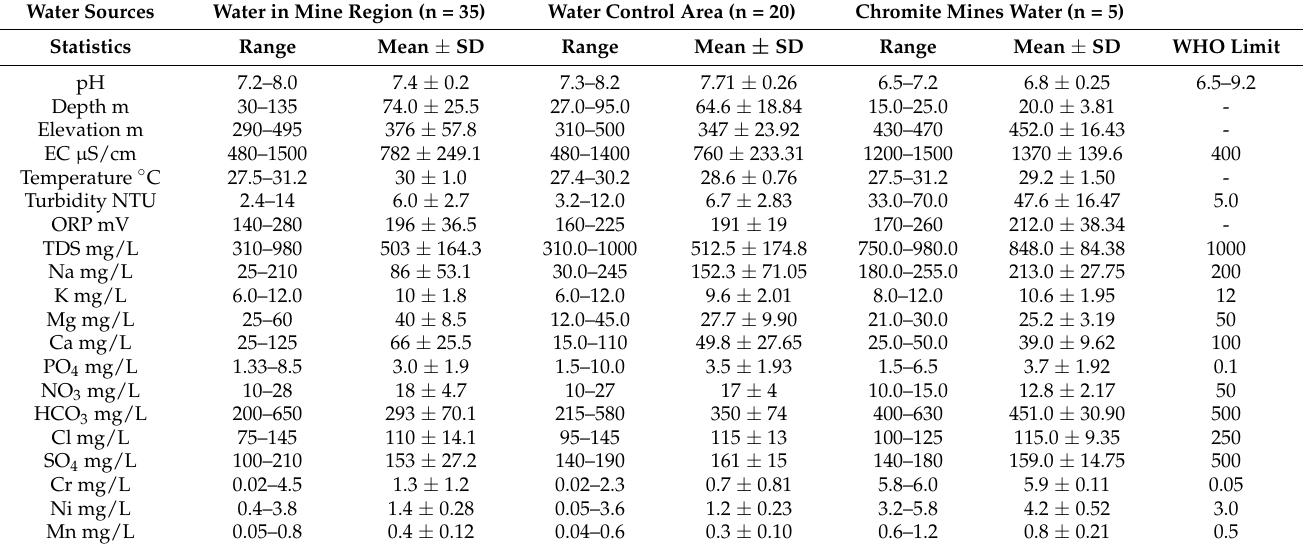
Table 1. Statistical summary of groundwater around extensive active chromite mines in the ultramafic terrain in Northern